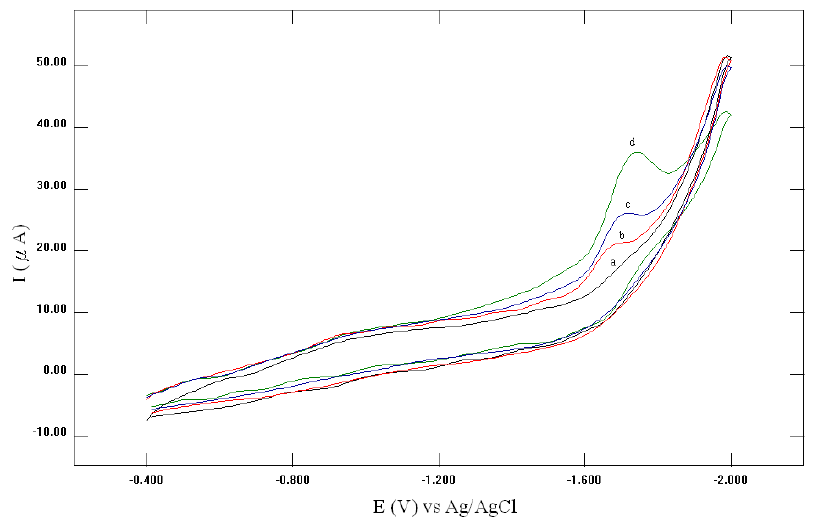
Figure 4 . Cyclic voltammograms of coumarin in Britton-Robinson (BR) buffer (pH 5.83) at a thin-film mercury-modified GCE (Hg/GCE). Concentrations: (a) 2.723 × 10 − 4 M; (b)